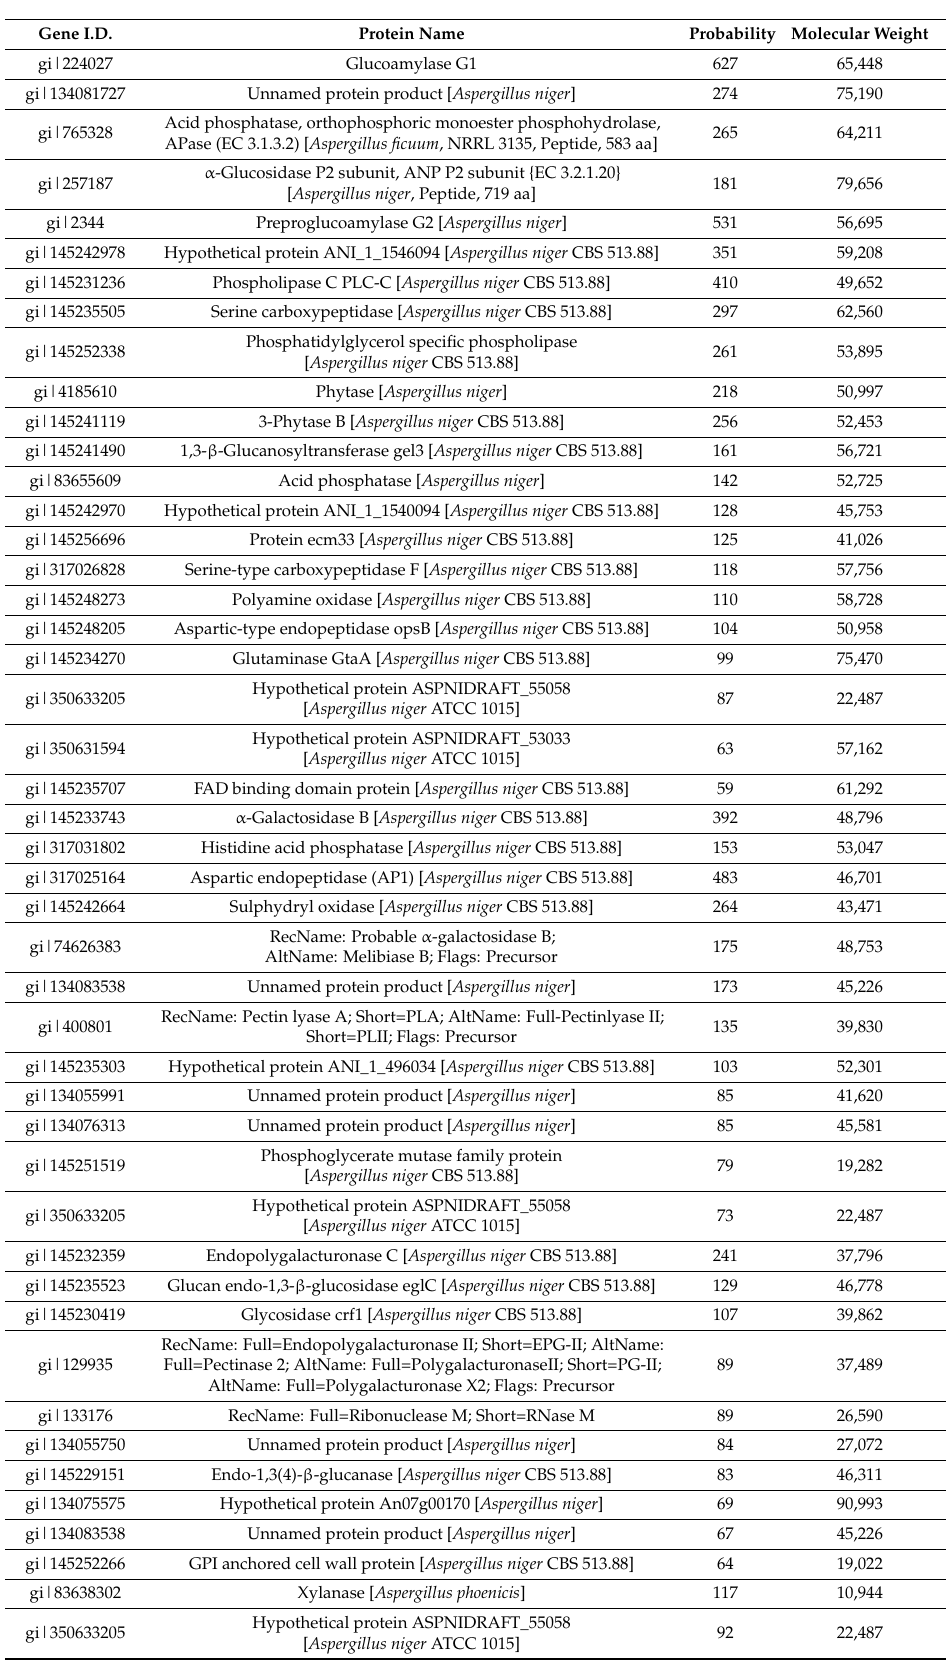
Table 2. Identification of proteins recovered from the secretory proteins from Aspergillus niger . Gene